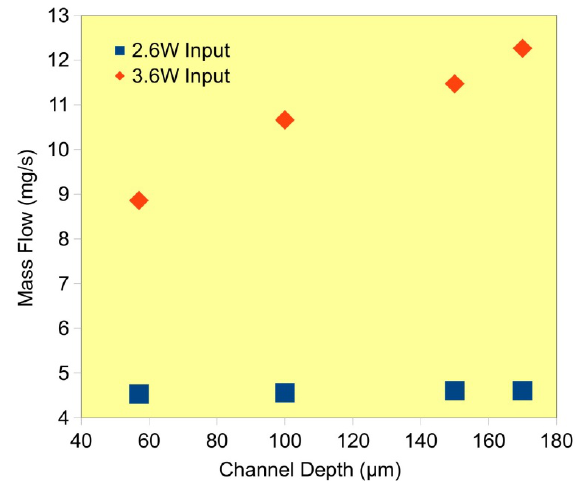
Figure 8. Mass flow vs . channel